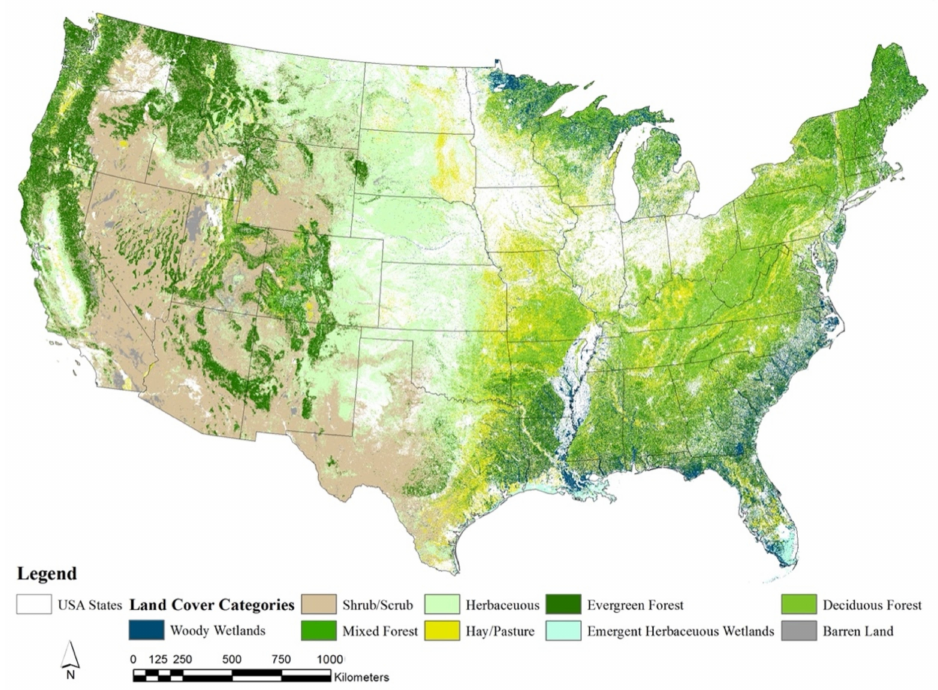
Figure 2. The National Land Cover Data (NCLD) displaying land cover categories used in summary steps in this